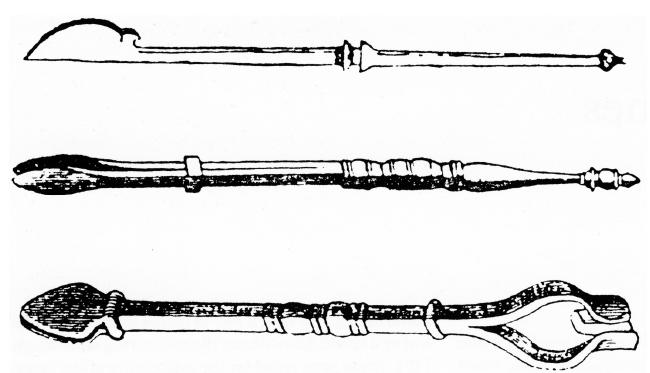
Figure 15. Roman Ruling Pens [52].